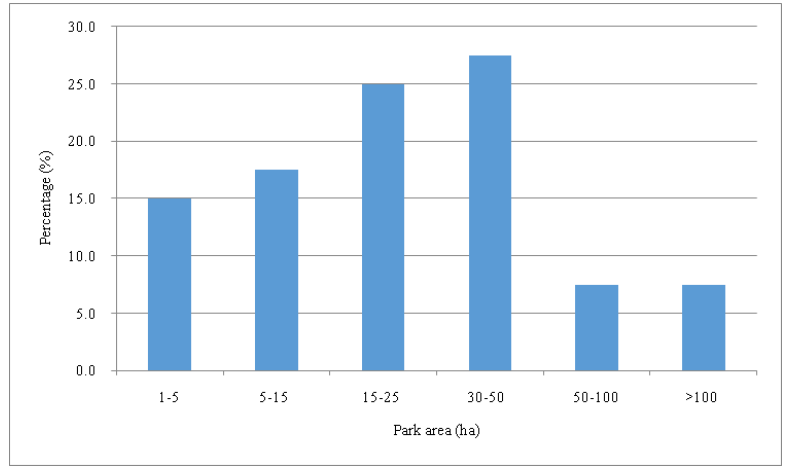
Figure 1. Number proportion of urban parks with different